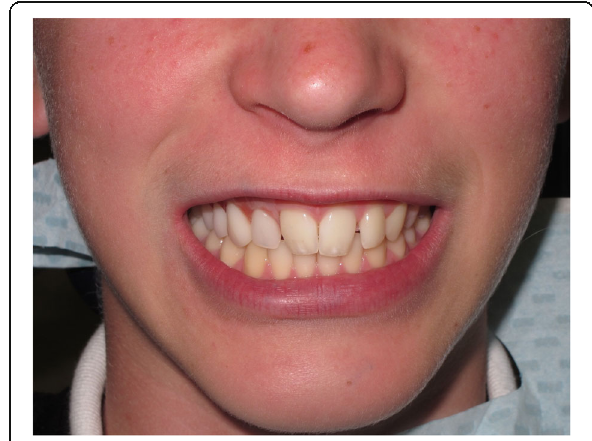
Fig. 7 Smile view of definitive implant-retained obturator at initial